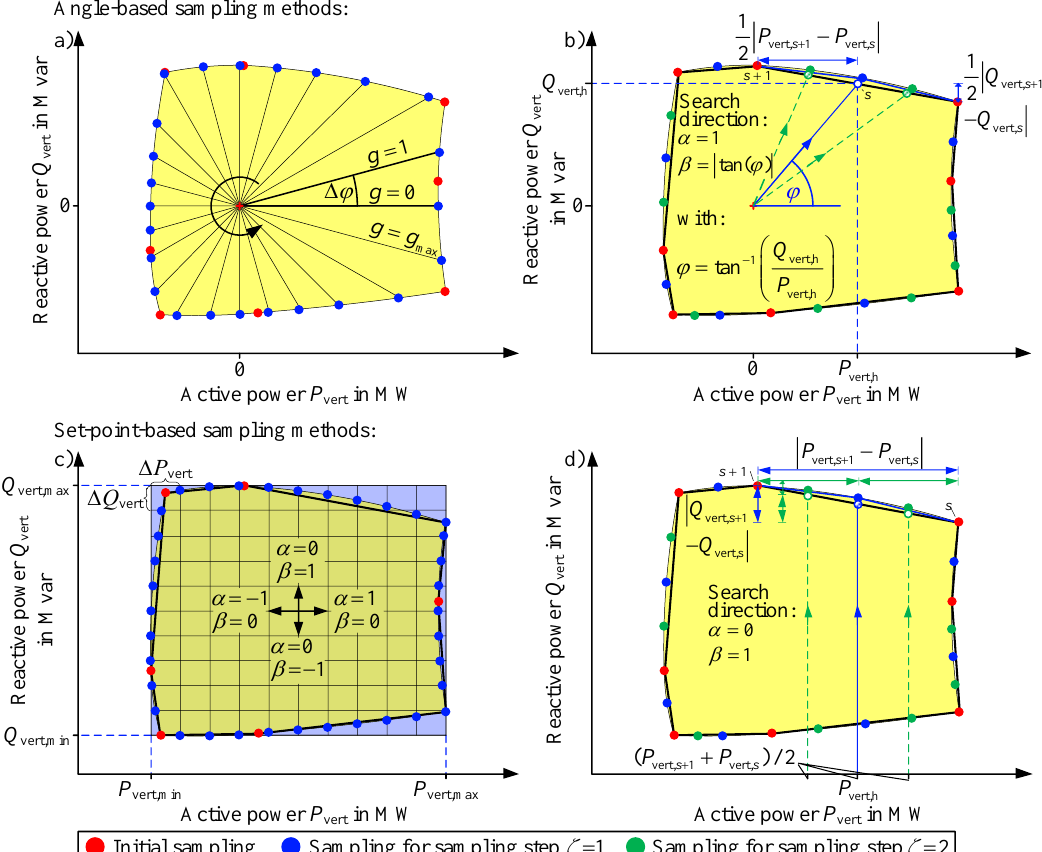
Figure 4. Sampling strategies for the determination of the FOR: ( a ) angle-based sampling strategy, ( b ) iterative angle-based sampling strategy, ( c ) set-point-based sampling strategy, ( d ) iterative set-point-based sampling